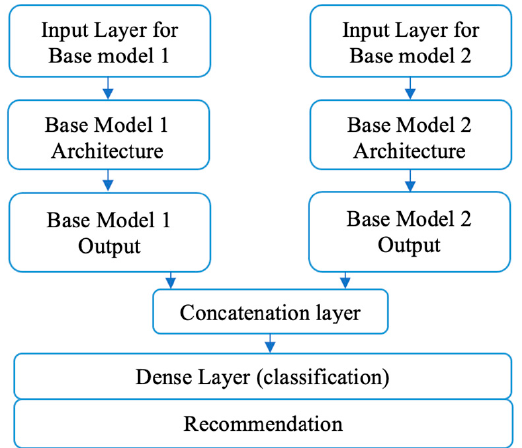
Figure 5. The E2DR (Pair-wise stacking)